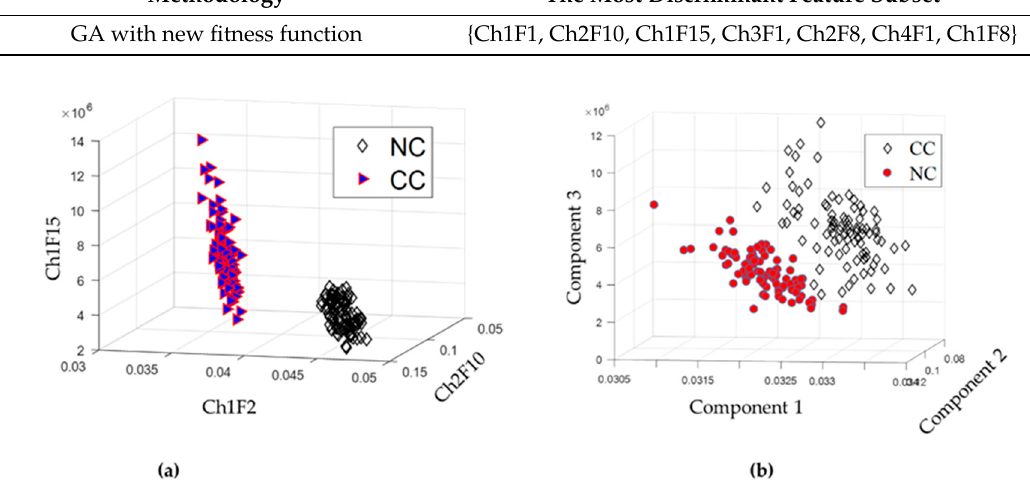
Figure 10. 3D visualization of the selected feature for ( a ) the proposed GA-based feature selection and ( b ) the first three components of PCA [23].